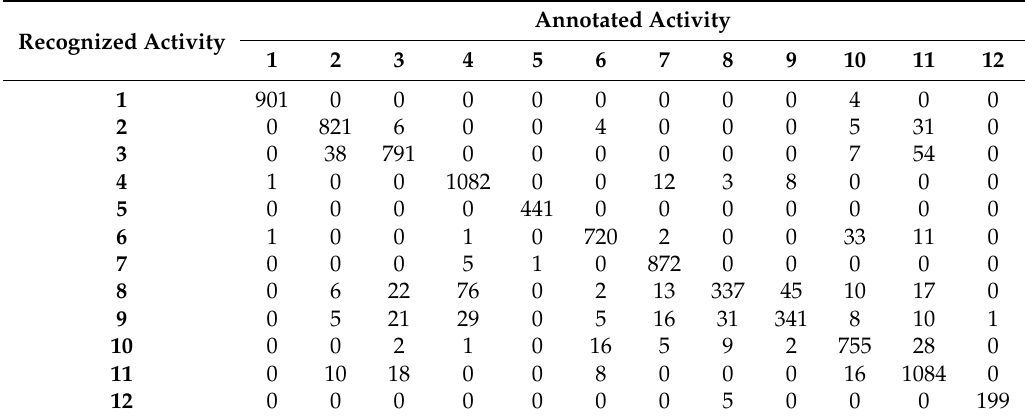
Table 4. Confusion matrix of training data with three sensors using instantaneous energy density (IE) as feature.